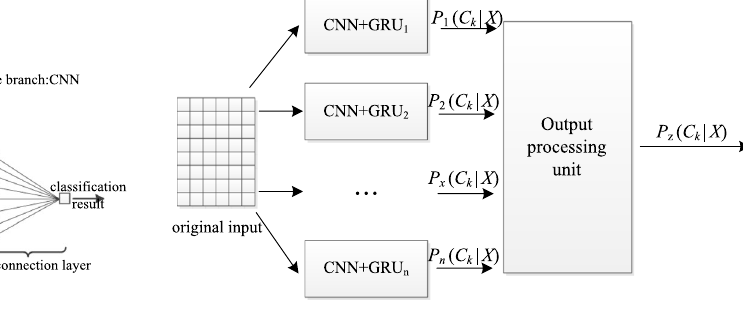
Fig. 3 The structure of MP CNN